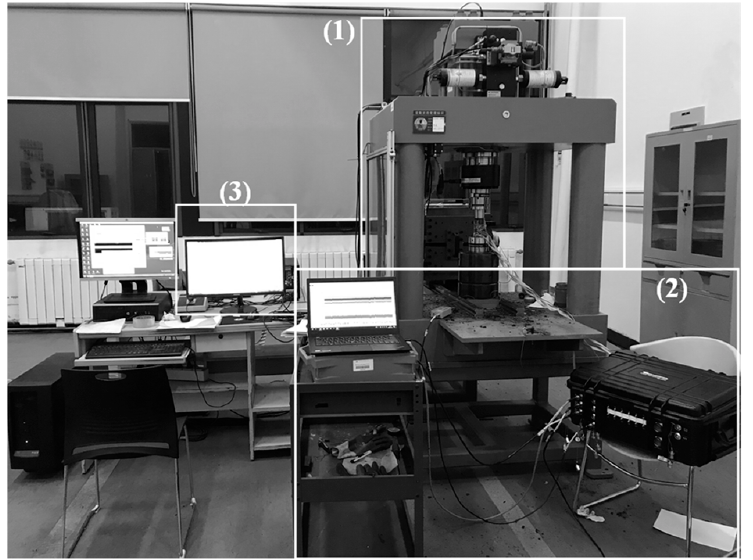
Figure 1. Experimental system for collection of stress, self-potential and acoustic emission data. MTS816 rock mechanics test machine (1), SEMOS-LAB experimental system (2) and acoustic emission test system (3).